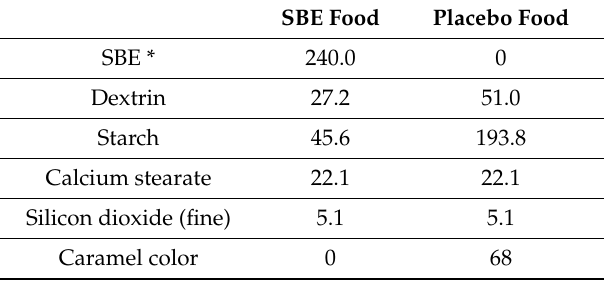
Table 1. Composition of standardized bilberry extract (SBE) and placebo foods (mg /